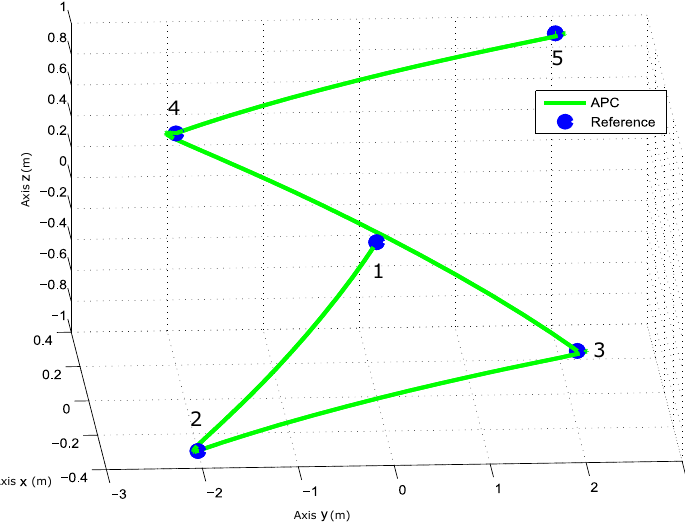
Figure 2. Three-dimensional simulation of a flight path response.